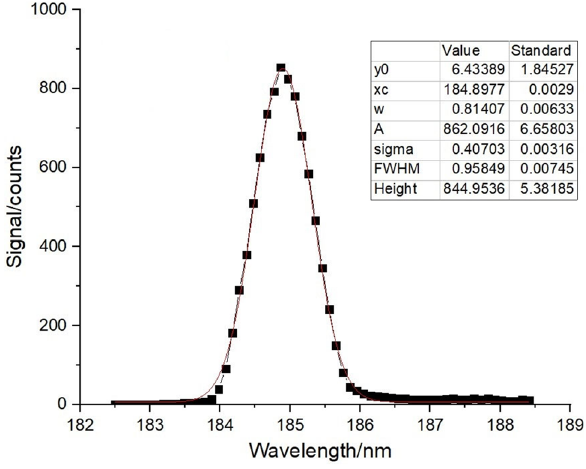
Figure 9. Spectral response and Gaussian fitting curve of mercury lamp at 184